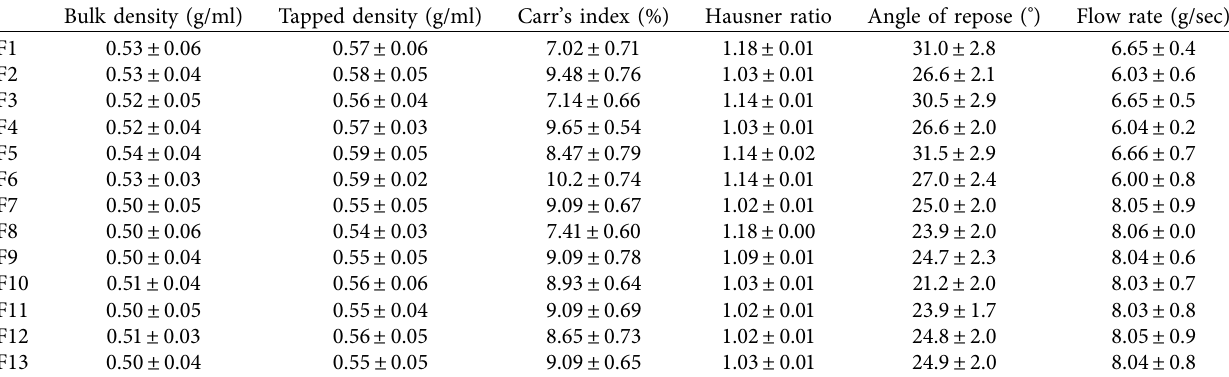
Table 2: Bulk density, tapped density, Carr’s index, and Hausner ratio of compression mixtures. Bulk density (g/ml) Tapped density (g/ml)